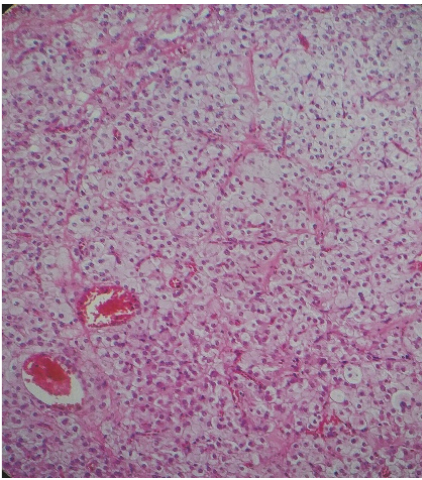
Figure 3: Leydig cell tumor composed by granular cells with eosinophilic cytoplasm and round nuclei (hematoxylin and eosin stain).